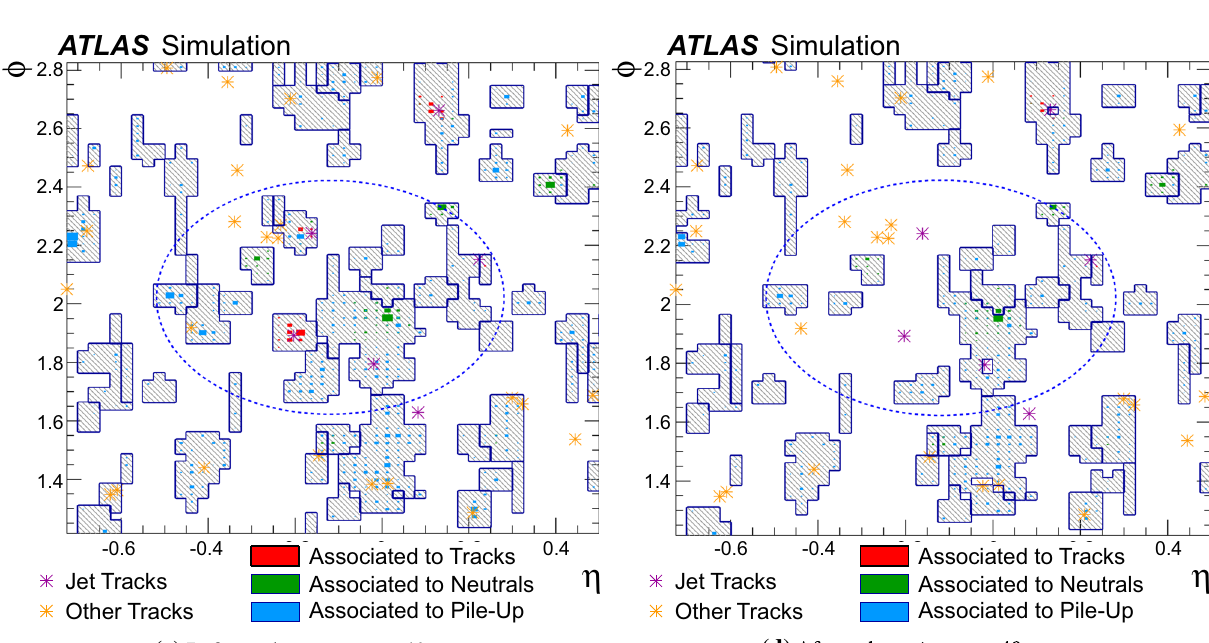
Fig. 22 A graphical display of the second layer of the EM calorime- ter focusing on a 30 GeV truth jet, outlined by the ellipse. Asterisks indicate the positions of tracks extrapolated to the calorimeter, while blue framed rectangles mark the cells clustered into topo-clusters. The colour purple ( dark ) is used to indicate those tracks that are selected for particle flow jet reconstruction, i.e. those matched to the nominal hard-scatter primary vertex (see Sect. 8) and clustered into the jet based